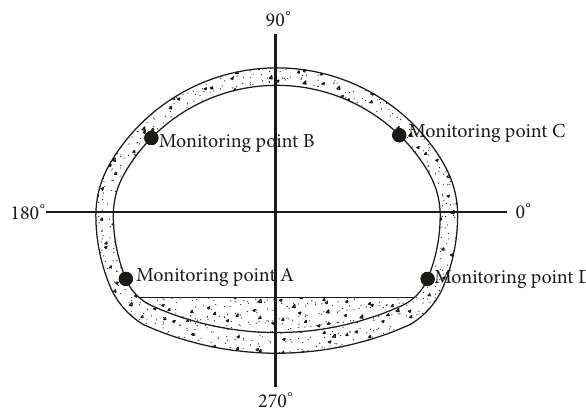
Figure 9: Monitoring points and division on lining of NBB